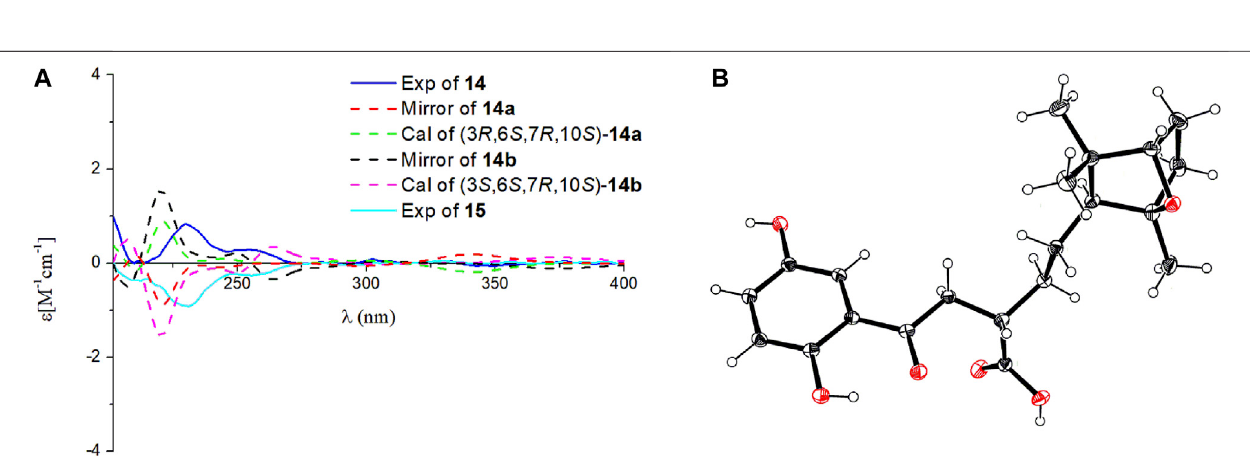
FIGURE 5 | Comparison of the calculated ECD spectrum of (3 R ,6 S ,7 R ,10 S )- 14a at CAM-B3LYP/def2SVP level, σ (cid:2) 0.20 eV, shift (cid:2) +10 nm; and the calculated ECDspectrumof(3 S ,6 S ,7 R ,10 S )- 14b atB3LYP/6-31G(d,p)level, σ (cid:2) 0.20 eV,shift (cid:2) +10 nm;withtheexperimentalCDspectraof 14 and 15 inMeOH (A) .Ortepplotof the X-ray crystallographic data of 15 . Anisotropic displacement ellipsoids display 50% probability levels (B) .